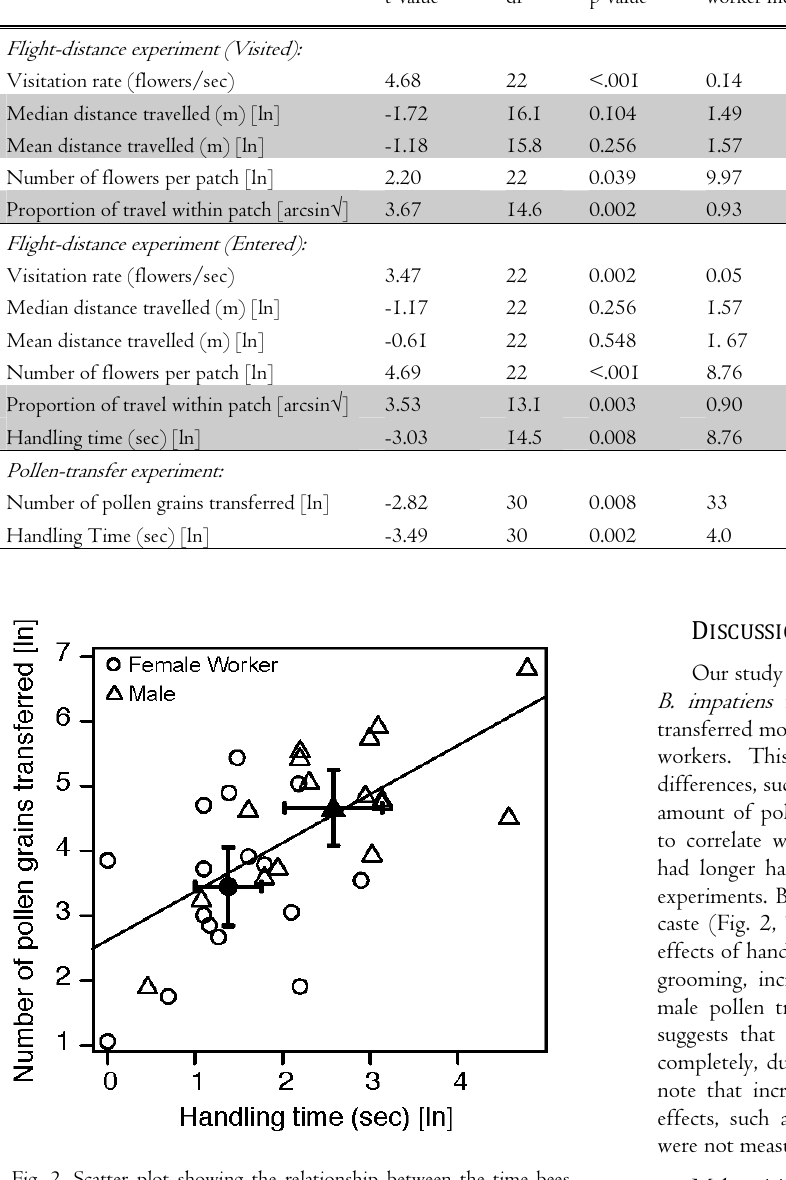
Fig. 2. Scatter plot showing the relationship between the time bees spend handling recipient flowers and the number of pollen grains they transfer to those flowers. Solid black line is based on a linear mixed effect model: response variable = ln(number of pollen grains transferred); fixed effect = ln(recipient flower handling time); random effect = experimental bout. The means and 95% confidence intervals for the handling time and number of pollen grains transferred by workers (solid black circle) and males (solid back triangle) are also